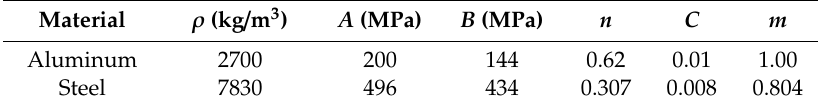
Table 2. Material parameters of the aluminum and